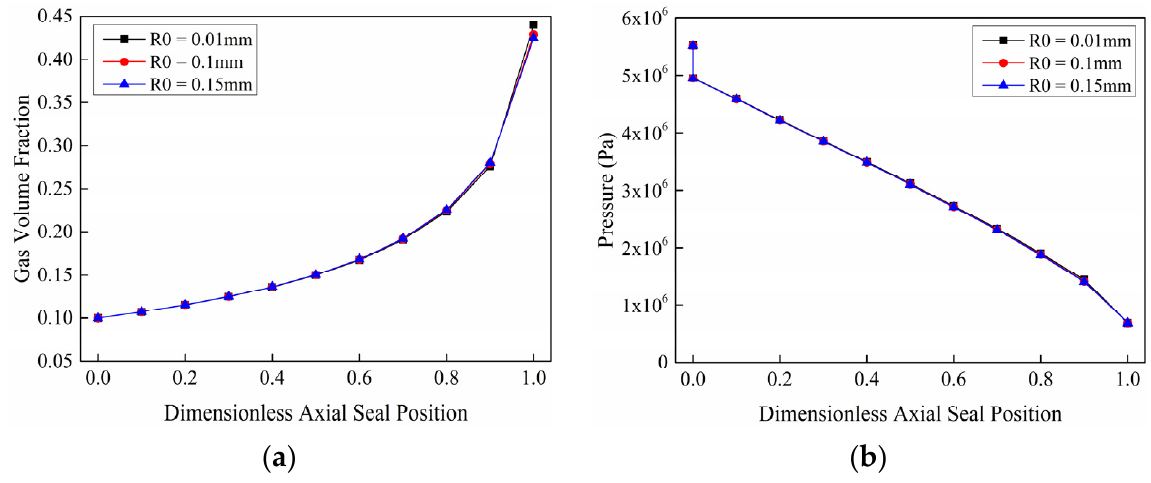
Figure 9. GVF and pressure distribution along the axial direction within the model seal under different bubble radii for Δ P = 48.3 bars. ( a ) GVF distribution, ( b ) pressure distribution.